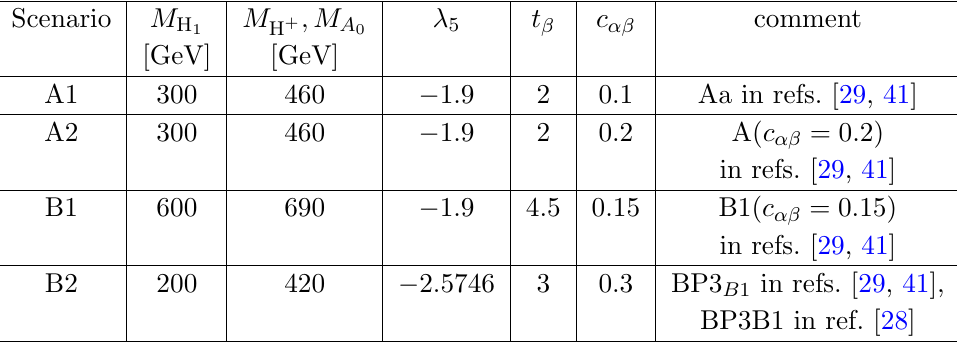
= 125 GeV, and c (cid:11)(cid:12) = cos( (cid:11) 2